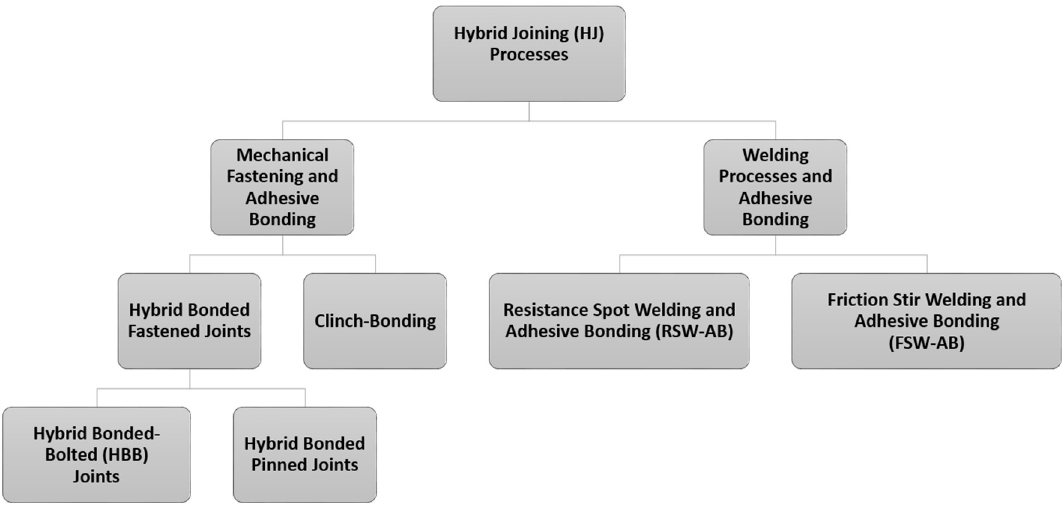
Figure 1. Graphical scheme of the structure of the techniques selected and described in the present